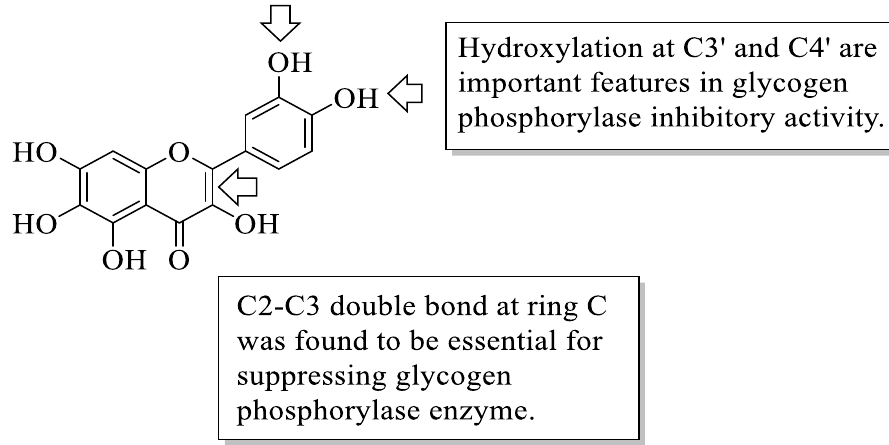
Figure 12. The structure of 44 and the functional groups responsible for the inhibition of glycogen phosphorylase